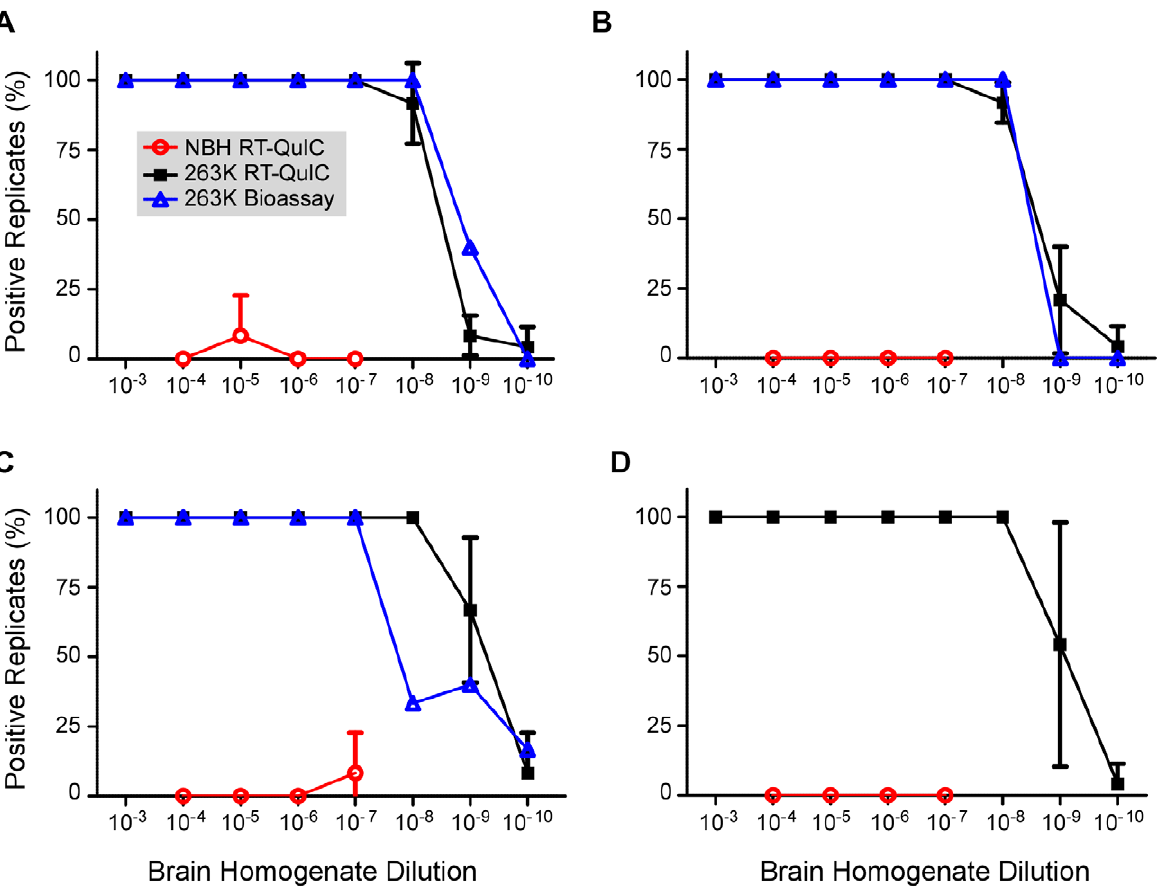
Figure 3. Combined RT-QuIC end-point dilution analyses from four scrapie BH stocks. Each 263K stock (Brain # 1- # 4 corresponding to Panels A-D) was serially diluted and used to seed RT-QuIC reactions. The percentage of replicate wells (n=4–8) that are ThT-positive according to the criteria in Material and Methods was calculated and the mean percentage 6 standard deviation from three separate experiments with each stock is shown. Animal bioassay data is represented as the percentage of replicate animals reaching the clinical stage of disease at each dilution of 263K scrapie BH (4–22 animals per dilution per stock).